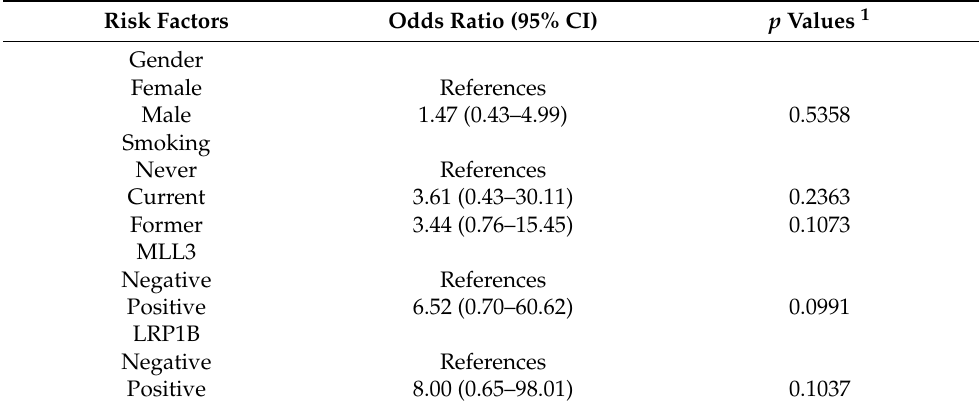
Table 5. Risk factors for irAEs by multivariate